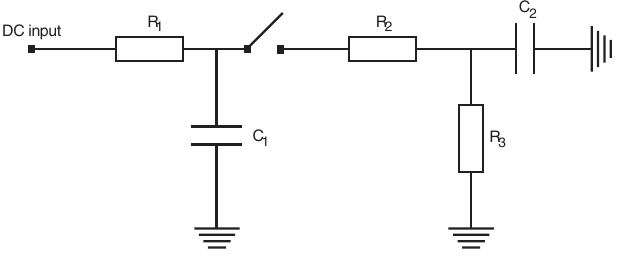
FIG. 6. Schematics of the transistor-based switch used to pro- duce a pulsed high voltage. The values of the components are (cid:4) 40 M(cid:2) , R (cid:4) 50 (cid:2) , R (cid:4) 5 k(cid:2) , C (cid:4) 2 nF , and C R 1 2 3 1 12 pF